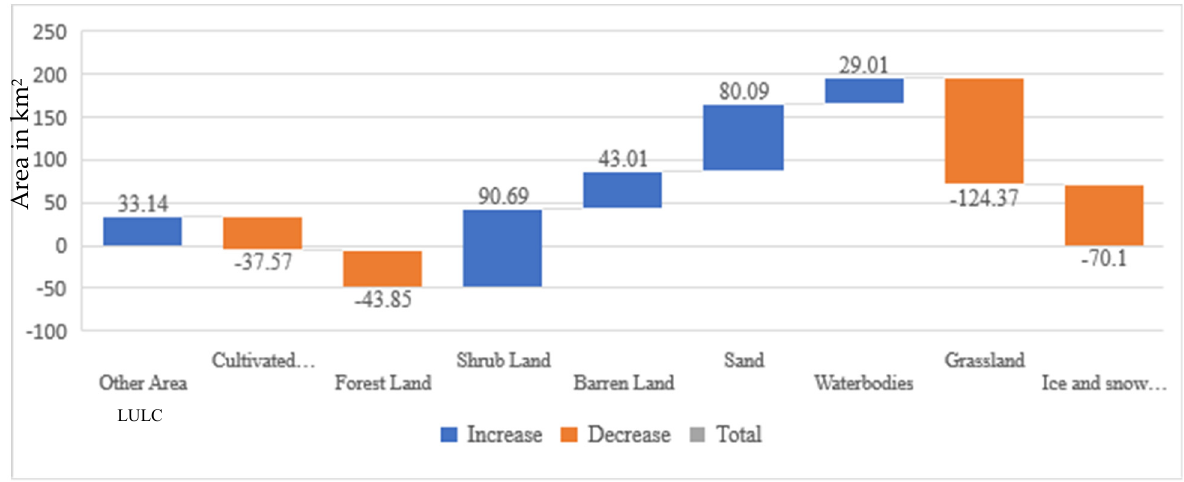
Figure 4. Gains and losses of LC classes between 1996 and 2006 (area in km 2 ) based on the total LC values. The major LC changes during this period include (a) overall increases in other